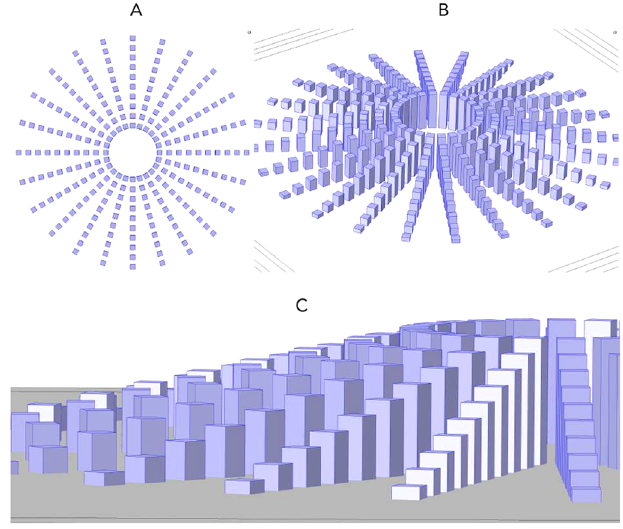
Fig. 3. Design of a large scale elastodynamic cloak in a plate with 10 concentric layers of pillars simulating buildings with height varying linearly from 10 m to 100m, of square cross section 20 m × 20 m, with centre to centre spacing of 40 m along the radial direction. The plate has thickness of 40 m and the cloak has diameter of 1000 m, with a protected area in the centre which is 200 m in diameter and buildings have parameters of concrete ( E =25e9 [Pa], r =2300 [kg/m 3 ], n = 0.2) with 20 m of interstitial distance in between